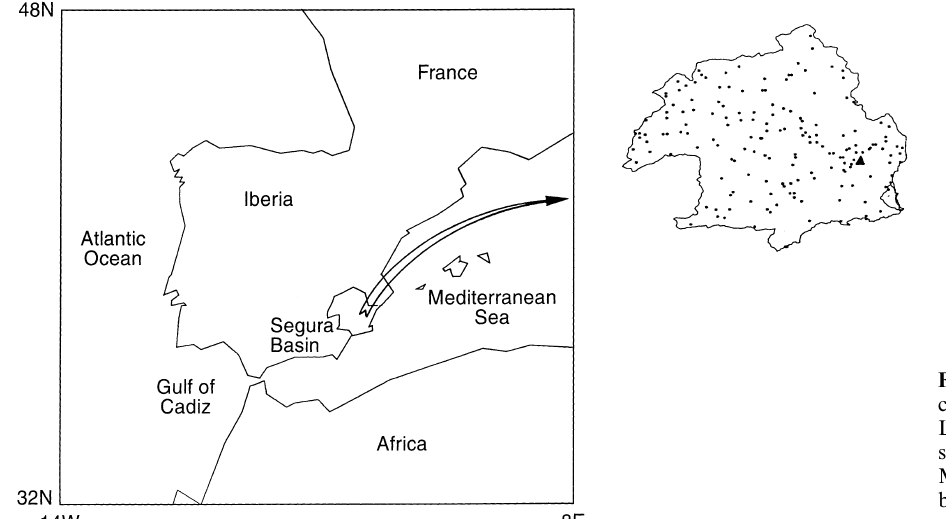
Fig. 1. Iberian Peninsula map indi- cating location of Segura Basin. Locations of precipitation gauges are shown by asterisks . Location of Murcia radiosonde station is shown by